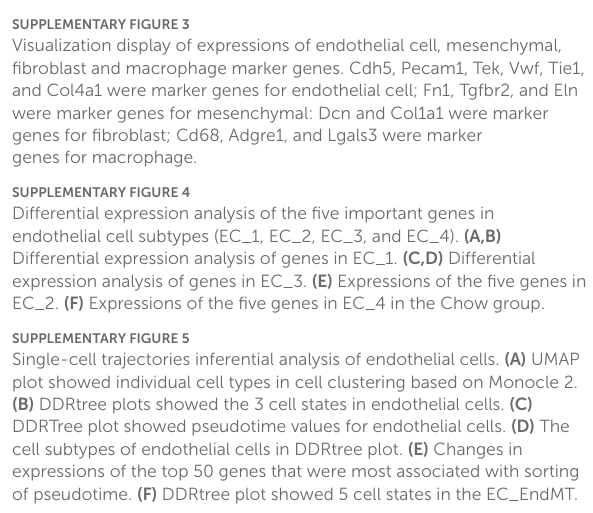
SUPPLEMENTARYFIGURE1 Quality control of single-cell RNA-seq data. (A) Maps showed the distribution of the main features of cells before quality control. Red dashed line represented the threshold used to perform data filtering. (B–E) Data quality assessment after single-cell RNA-seq data filtering. SUPPLEMENTARYFIGURE2 Cell clustering and annotation process for single cell analysis. (A) UMAP plot showed cell aggregation in Chow and DDC groups. (B) UMAP plot showed the number and distribution of cell clusters after cell clustering. (C) UMAP plots showed the initial cell annotation of cell clusters by application of SingleR. The left side was based on MouseRNAseqData reference dataset, while the right side was based on ImmGenData reference dataset. (D) Violin plots of cell cluster and lineage marker gene. SUPPLEMENTARYFIGURE3 Visualization display of expressions of endothelial cell, mesenchymal, fibroblast and macrophage marker genes. Cdh5, Pecam1, Tek, Vwf, Tie1, and Col4a1 were marker genes for endothelial cell; Fn1, Tgfbr2, and Eln were marker genes for mesenchymal: Dcn and Col1a1 were marker genes for fibroblast; Cd68, Adgre1, and Lgals3 were marker genes for macrophage. SUPPLEMENTARYFIGURE4 Differential expression analysis of the five important genes in endothelial cell subtypes (EC_1, EC_2, EC_3, and EC_4). (A,B) Differential expression analysis of genes in EC_1. (C,D) Differential expression analysis of genes in EC_3. (E) Expressions of the five genes in EC_2. (F) Expressions of the five genes in EC_4 in the Chow group. SUPPLEMENTARYFIGURE5 Single-cell trajectories inferential analysis of endothelial cells. (A) UMAP plot showed individual cell types in cell clustering based on Monocle 2. (B) DDRtree plots showed the 3 cell states in endothelial cells. (C) DDRTree plot showed pseudotime values for endothelial cells. (D) The cell subtypes of endothelial cells in DDRtree plot. (E) Changes in expressions of the top 50 genes that were most associated with sorting of pseudotime. (F) DDRtree plot showed 5 cell states in the